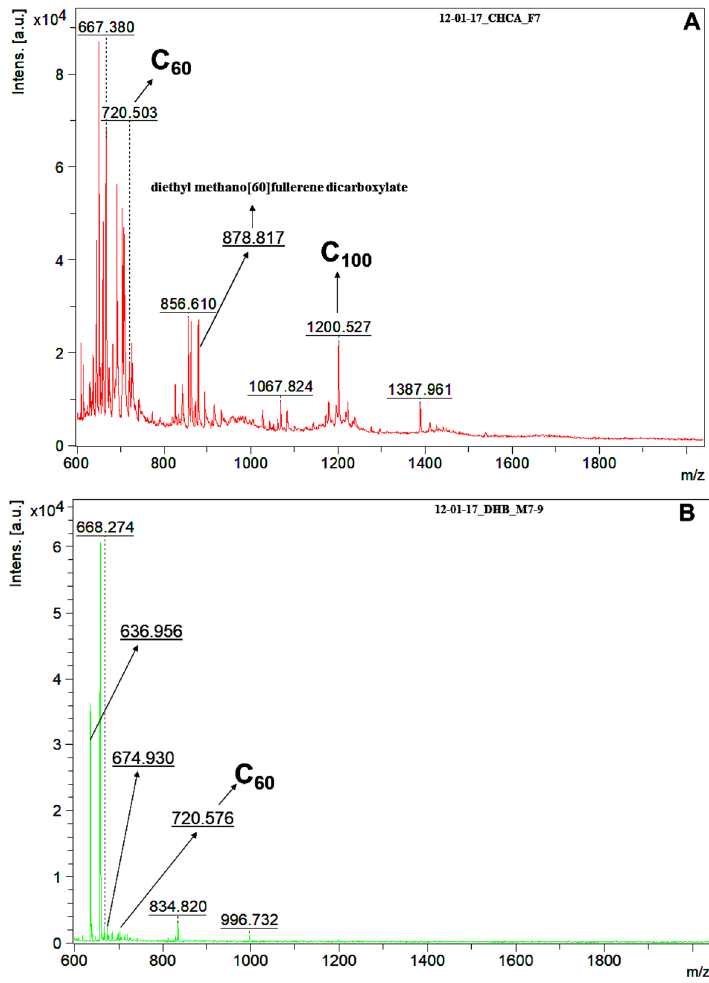
Figure 1. MALDI-MS profile of a fine aerosol sample. Typical spectra of the filter samples showing some fullerenes and matrix effect of the α-cyano-4-hydroxycinnamic acid—CHCA ( A ) and the 2,5-dihydroxybenzoic acid—DHB ( B ) matrices on detected fullerene ions.